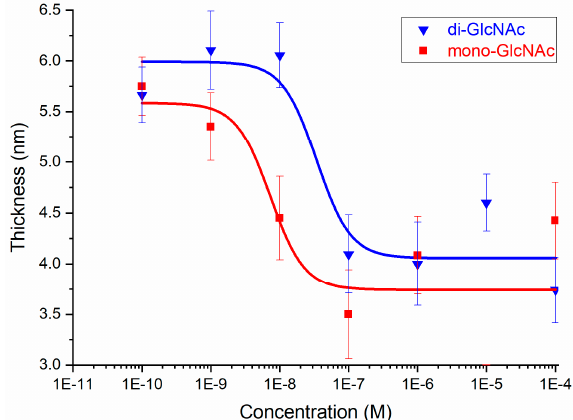
Figure 5. Comparison of the WGA binding curves obtained by AFM for mono- and di-GlcNAc - grafted graphene when in competition with free mono-GlcNAc ligand in solution. The curves were fitted with the Hill function with a fixed Hill coefficient of 1.75, as given in the literature [37]. The height drop for di-GlcNAc -grafted graphene occurred at about a five times higher competitor concentration than for the mono-GlcNAc -grafted graphene. The dependence of the dissociation constant on the chitooligomer length confirms the specificity of carbohydrate–lectin binding.